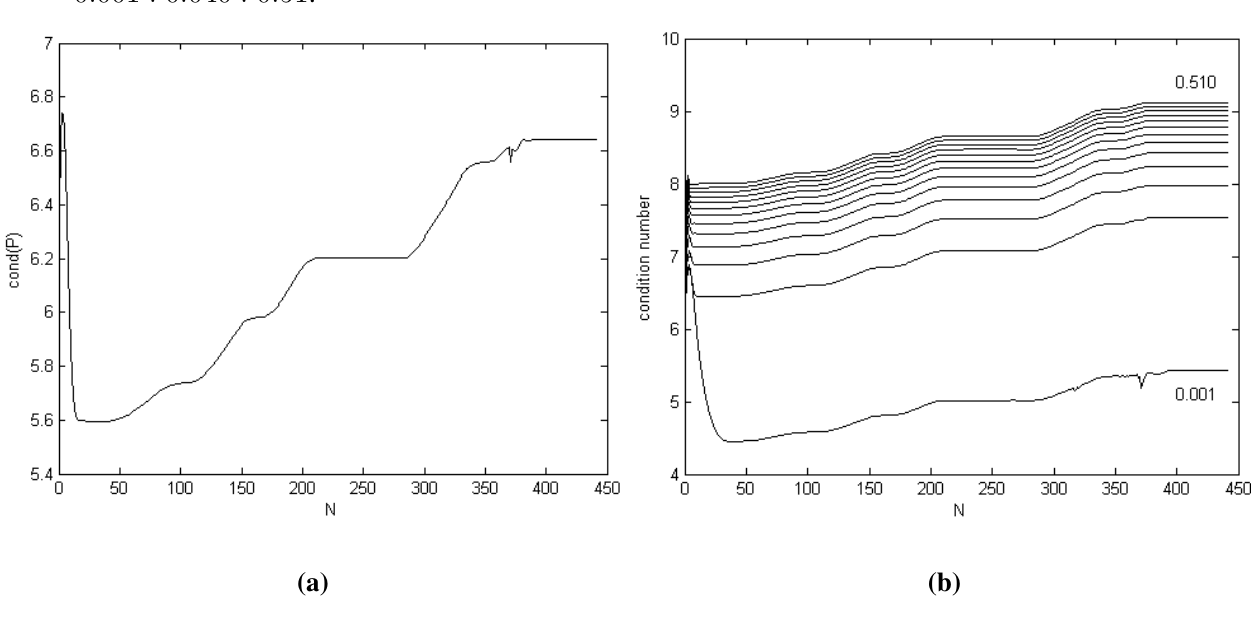
Figure 3. Condition number of matrix P + 0 . 001 : 0 . 040 : 0 . 51